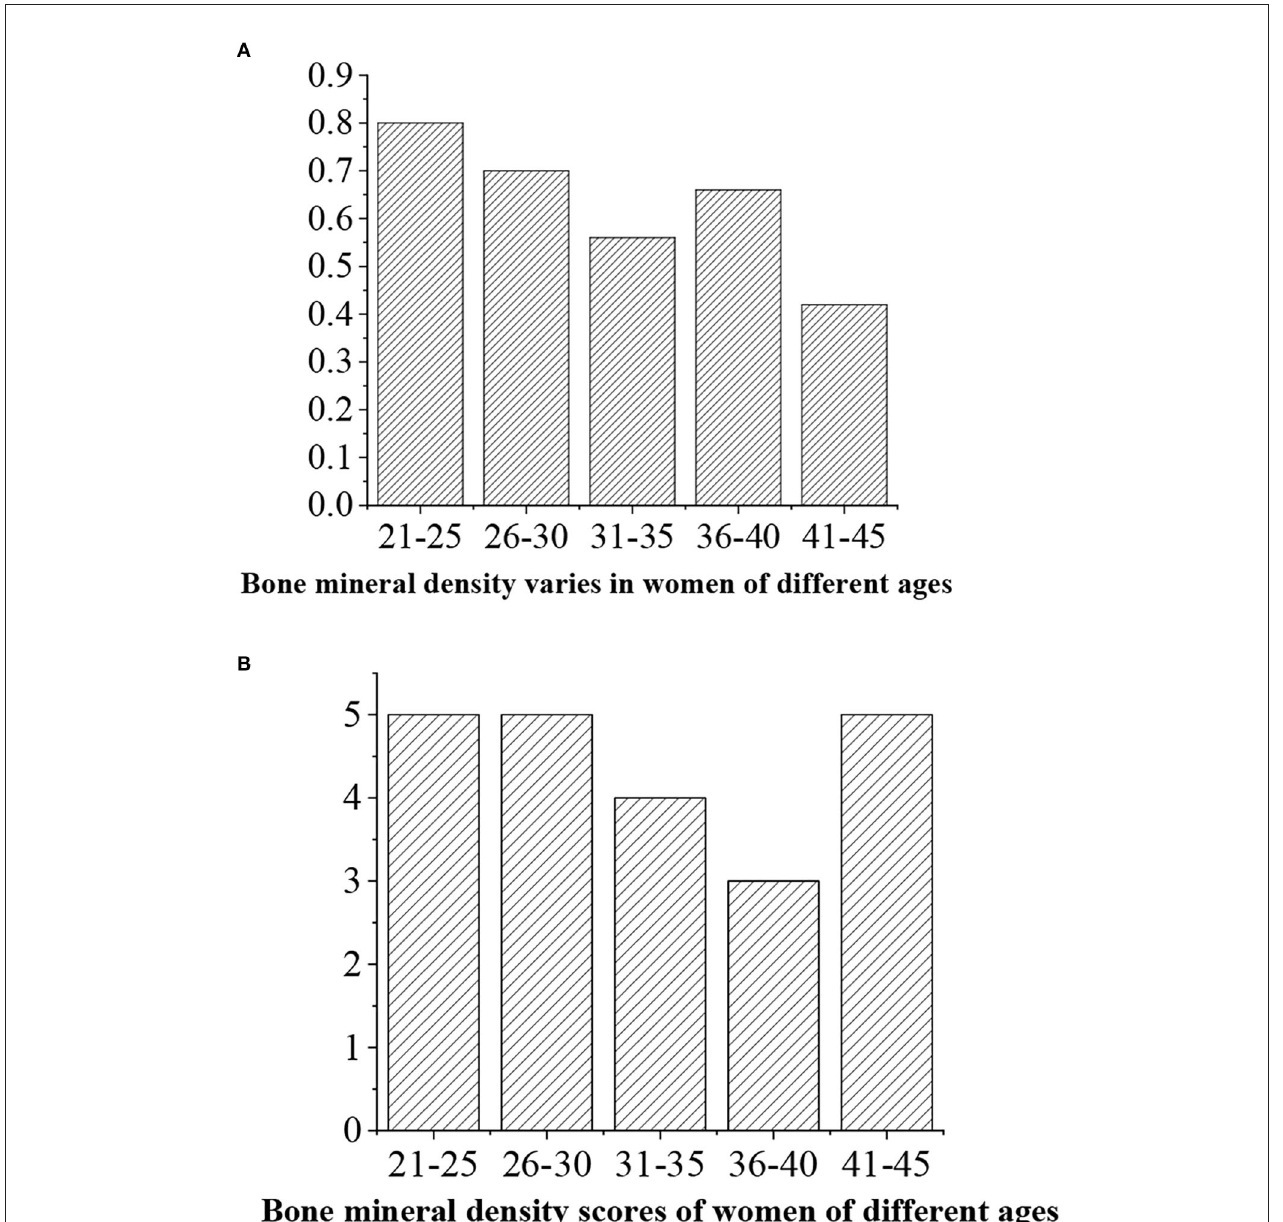
FIGURE 17 | (A) Statistical average bone density value for women of different ages. (B) Bone density